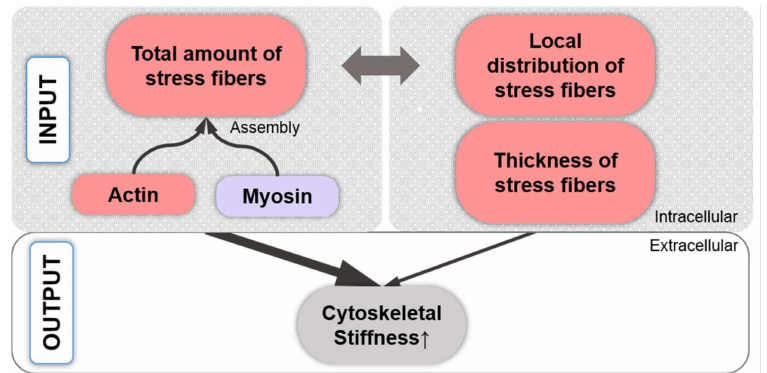
Figure 9. Correlation between cytoskeletal stiffness and SF amount vs. SF thickness and distribution. SF amount assembled of actin and myosin (with myosin having a higher impact) have a greater effect on global cell stiffness than SF thickness and alignment. The bold arrow indicates a larger effect than the regular arrow in the output section. The up arrow indicates an increase.